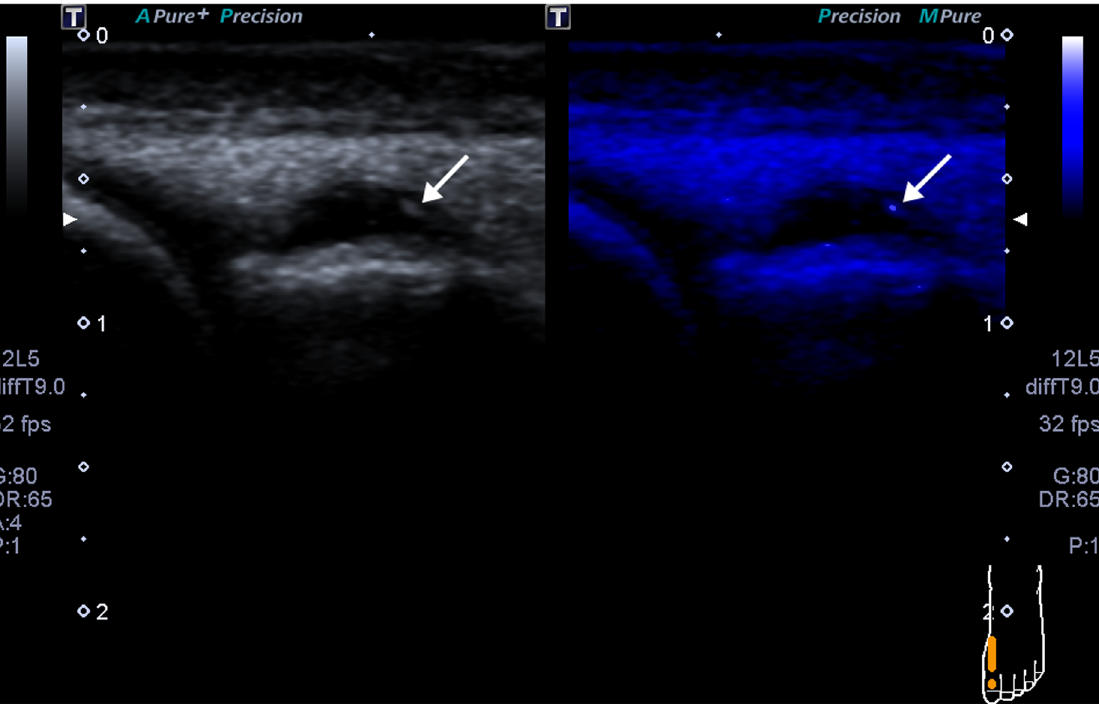
Figure 2. Longitudinal sonograms of the 1st MTP joint. Left: gray-scale US image; Right: MicroPure image. There is a microcalcification in the articular cavity that could not be clearly seen on the gray-scale image (left arrow), but it could be observed on the MicroPure image (right arrow).